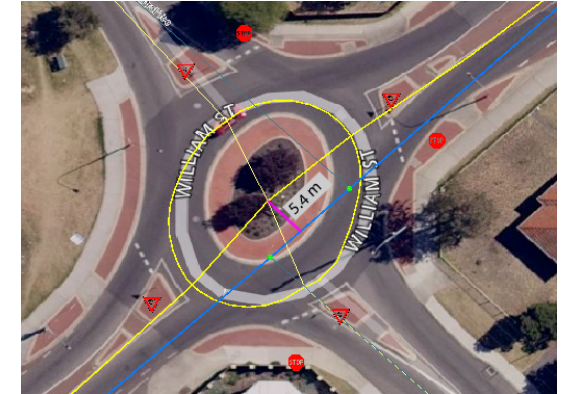
Figure 6. The illustration shows multiple data sets plotted on a geo-referenced image (sources: http://data.wa.gov.au (data); https://www.spookfish.com (image)).